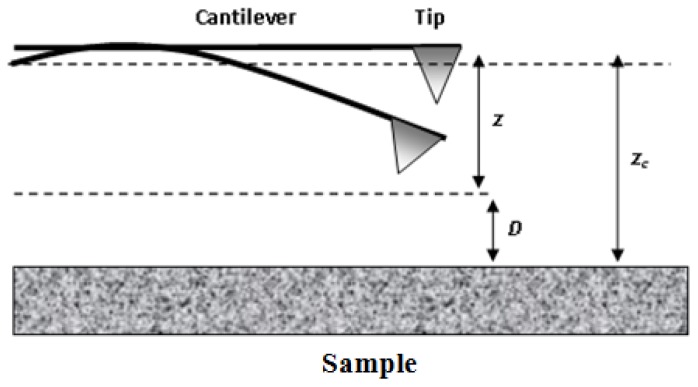
Scheme of the relevant spatial distances in AFM. D is the tip-sample distance, whereas zc is the distance between the sample and the cantilever rest position, and z is the cantilever deflection.